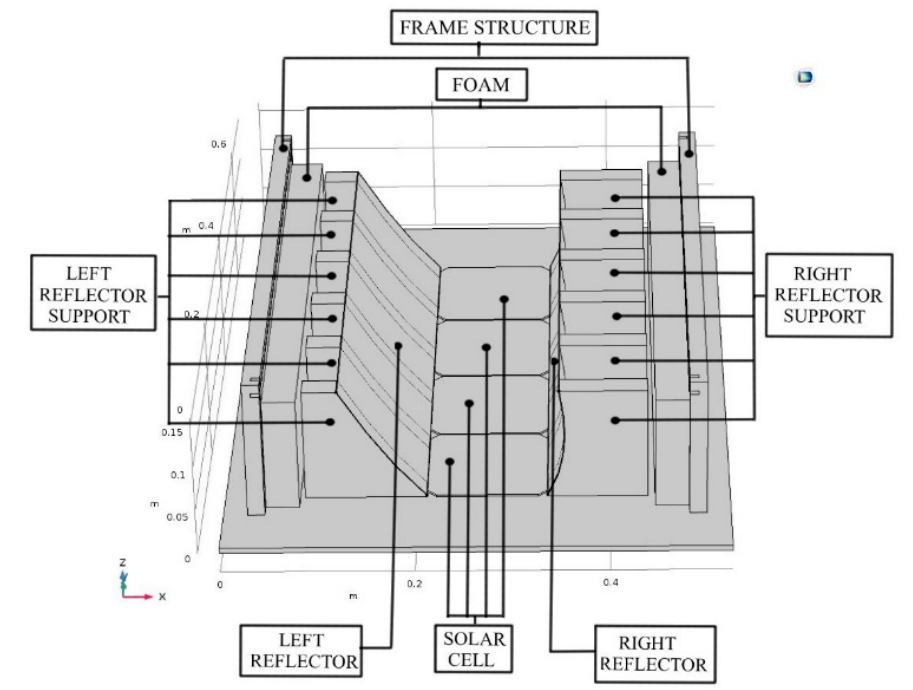
Figure 5. Inner components of the whole CPC system.